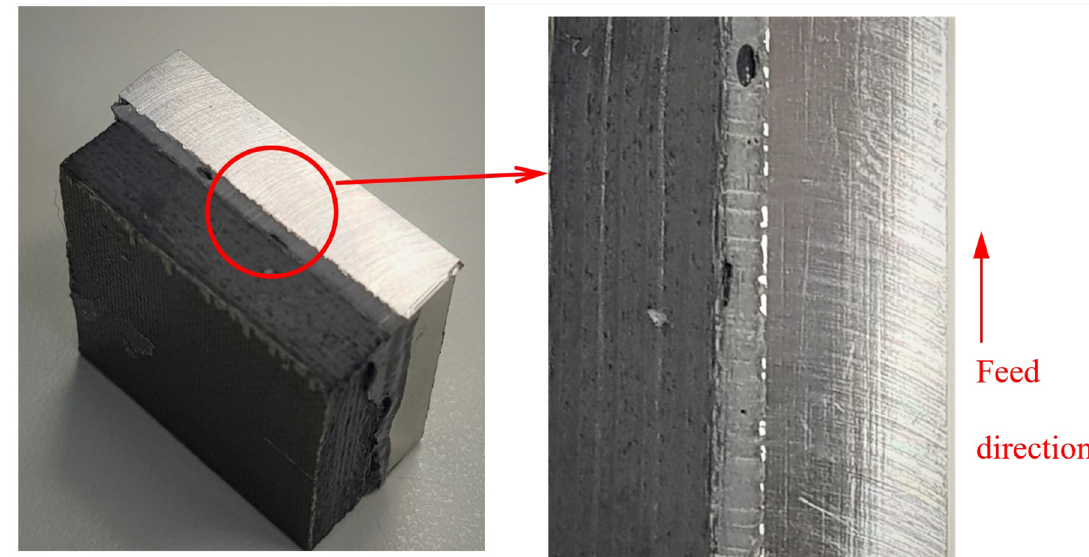
Figure 1. Milled sample Table 1.